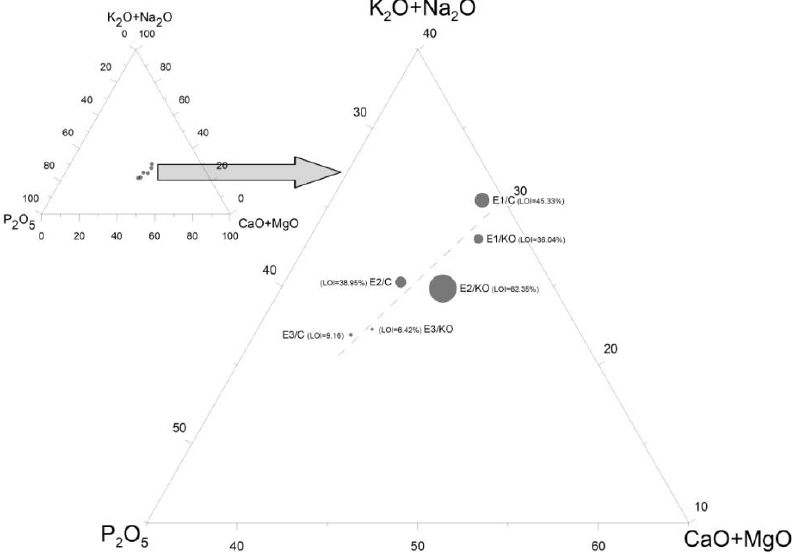
Figure 5. Ternary Bubble Plot in a system CaO + MgO—K 2 O + Na 2 O—P 2 O 5 , taking into account the LOI as a proportion of the bubble diameter.